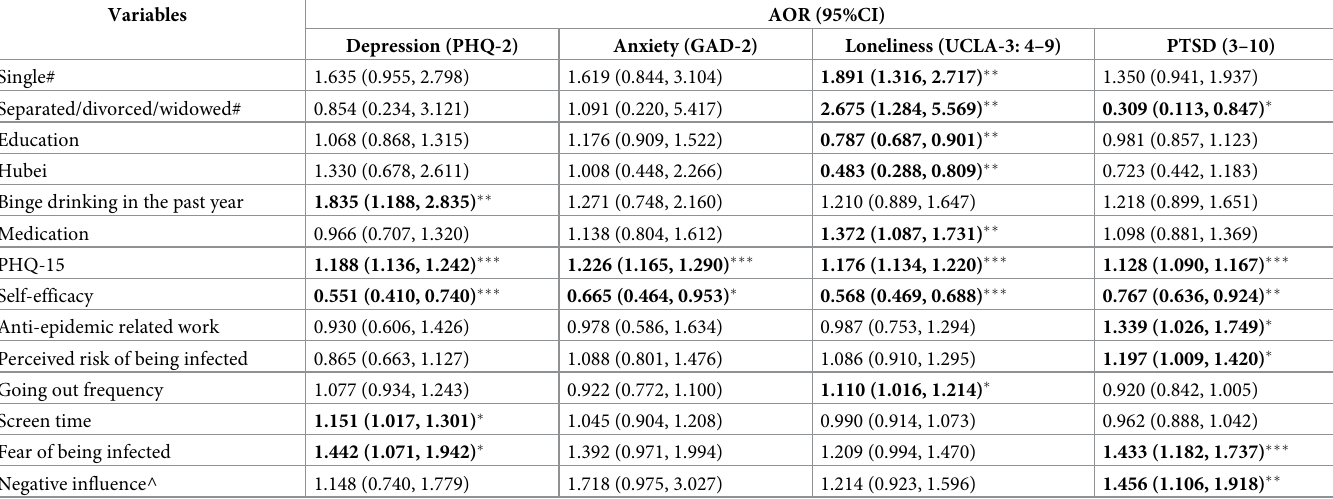
Table 3. Significant risk factors influencing mental health outcomes in multiple logistic regression